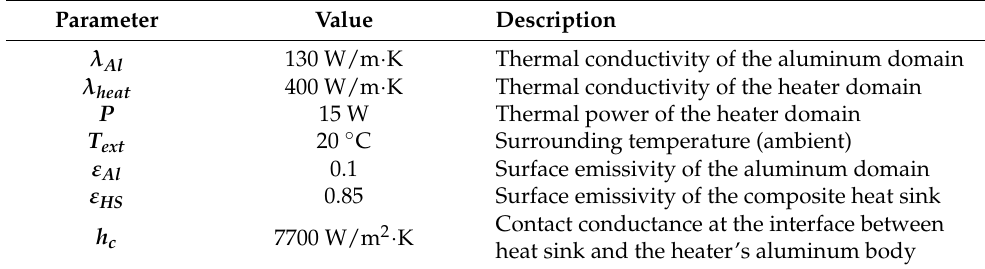
Table 1. Input parameters of the numerical model.